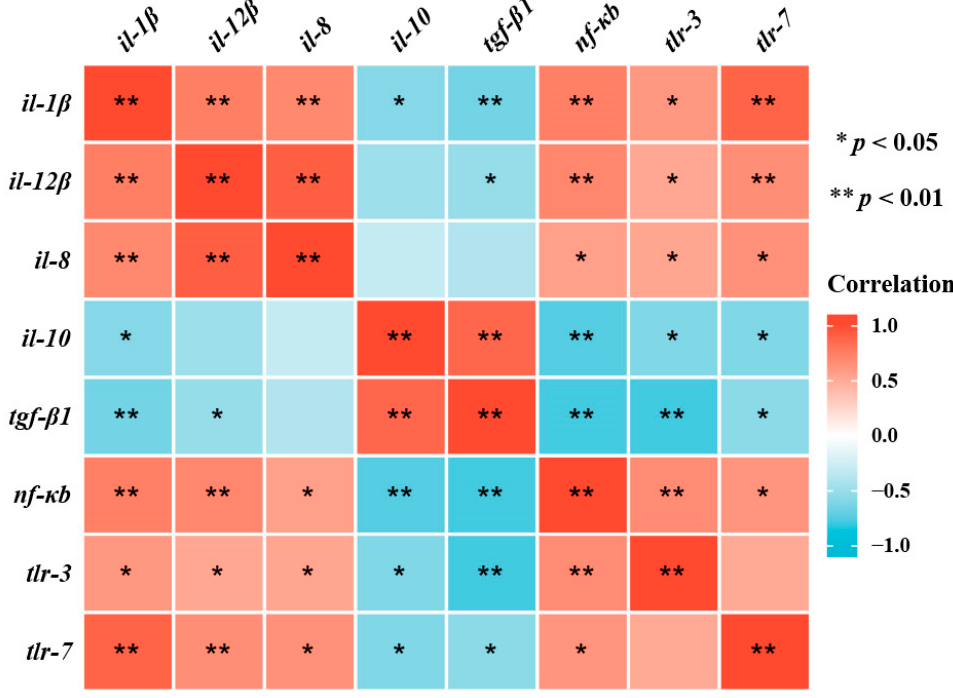
Figure 6. Correlative analysis of liver-inflammation-related gene expression. * p < 0.05, ** p <